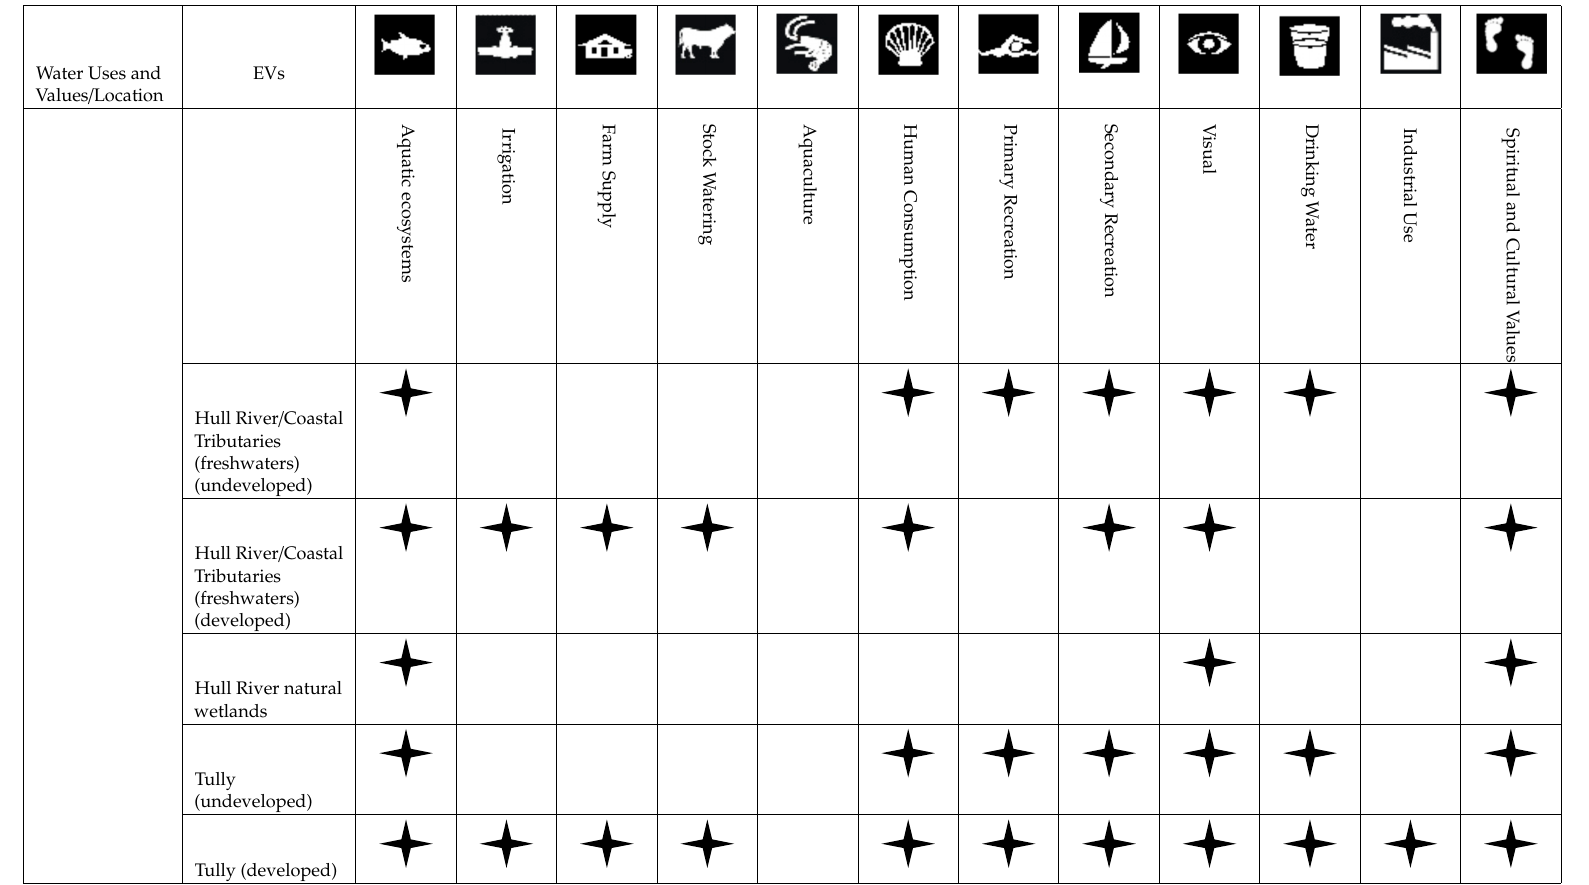
Table A1. List of EVs * Summarised for the Tully Basin EVs (as a result of this current research.